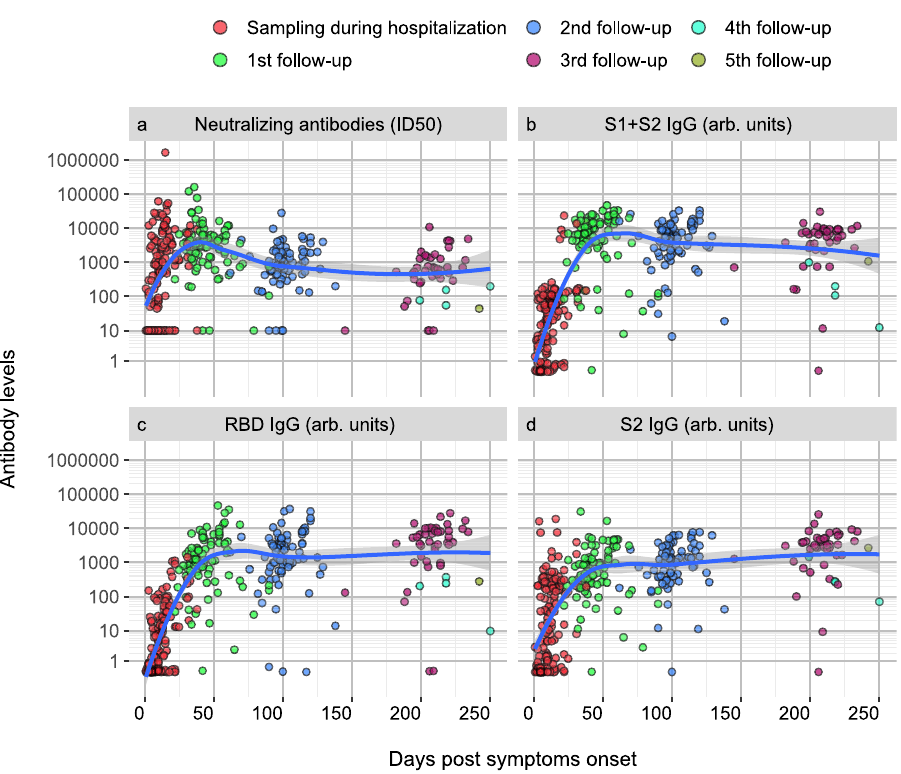
Fig. 2 Kinetics of the anti-Spike antibody response. Scatterplots of each patient anti-spike neutralizing ( a ), S1 + S2 IgG ( b ), RDB IgG ( c ), S2 ( d ) IgG antibodies over time from symptoms onset. Antibody levels correspond to the reciprocal of the ID50 for nAbs or to arbitrary units for all other reactivities. Sampling during hospital attendance (ER or ward) or at post-discharge outpatient follow-up visits is shown by the indicated color code. The moving average of data + SE (black curve line + gray band), as obtained by a LOESS curve fi tting polynomial regression, is displayed. Source data are provided as a Source Data fi